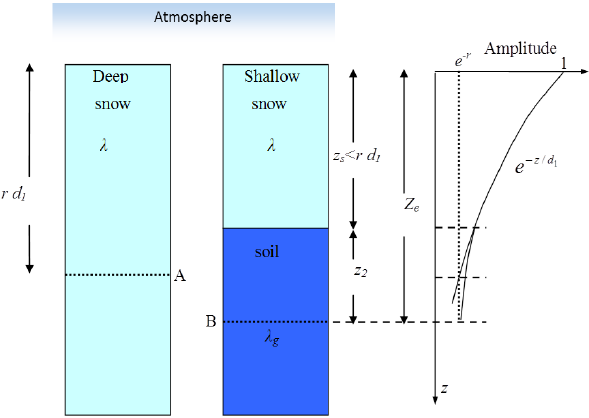
Figure 1. Schematic illustration of temperature profile during the downward propagation of a refreezing front. Figure 2. Heat conduction scheme for combined snow/soil system. The dashed lines at depths A and B indicate the depths at which temperature fluctuation amplitude is damped by e − r in the deep snow and combined snow/soil system,